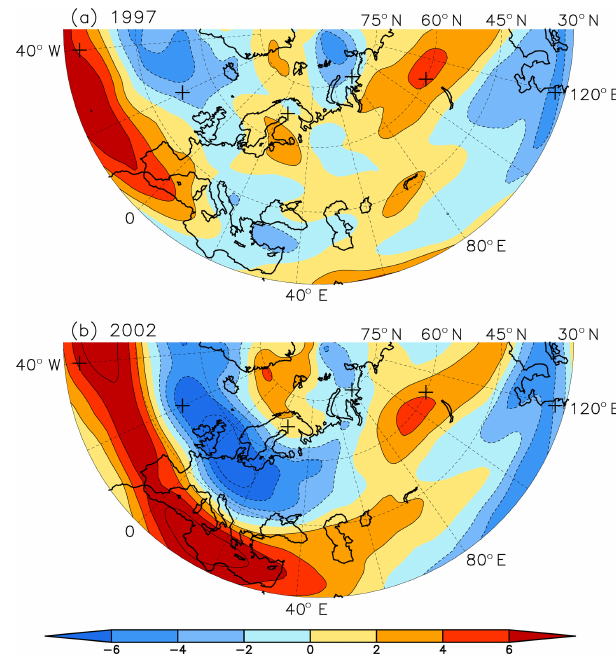
Figure 9. Horizontal distribution of the divergence (10 − 5 s − 1 ) at 300hPa during the winters of (a) 1997 and (b) 2002. The crosses denote the centers of action of the AEA